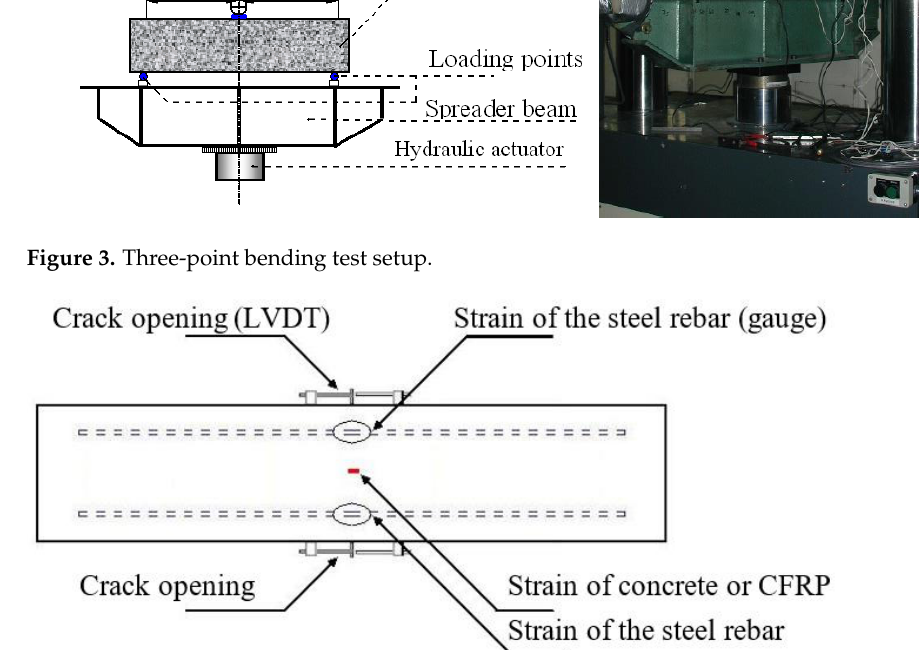
Figure 3. Three-point bending test setup.